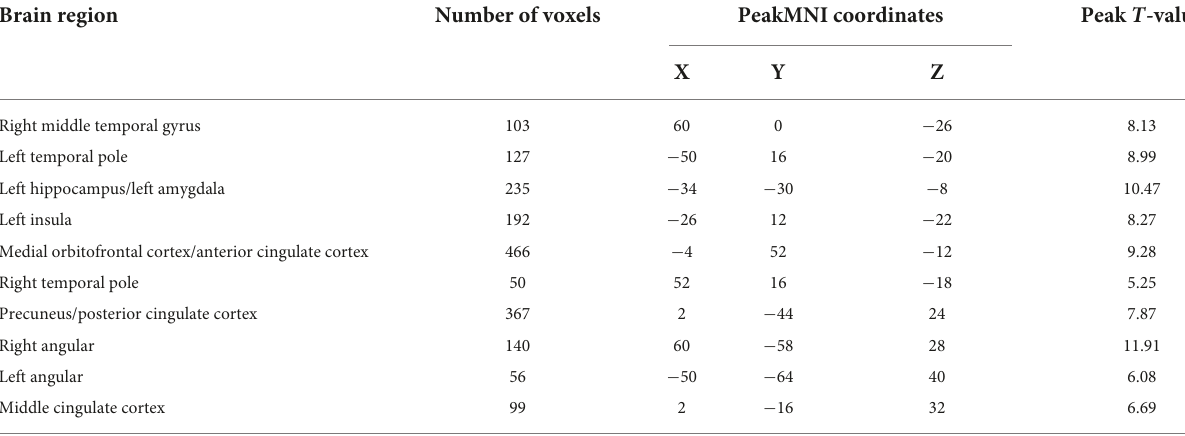
TABLE 2 Brain regions showing significant decreased left SFGmed-based functional connectivity in the aSAH group as compared to the healthy controls. Brain region Number of voxels PeakMNI coordinates Peak T -value